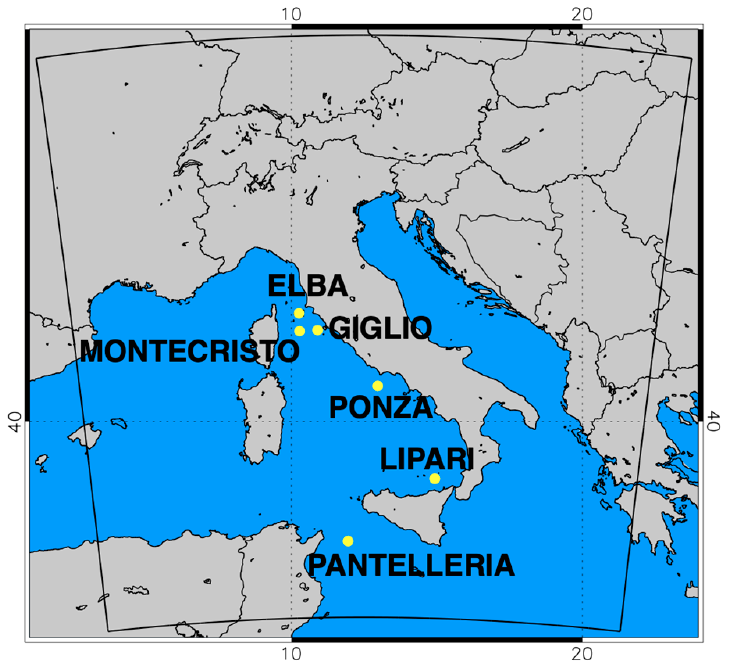
Figure 1. Weather research and forecasting (WRF) model domain. Yellow dots represent the small islands’ positions.